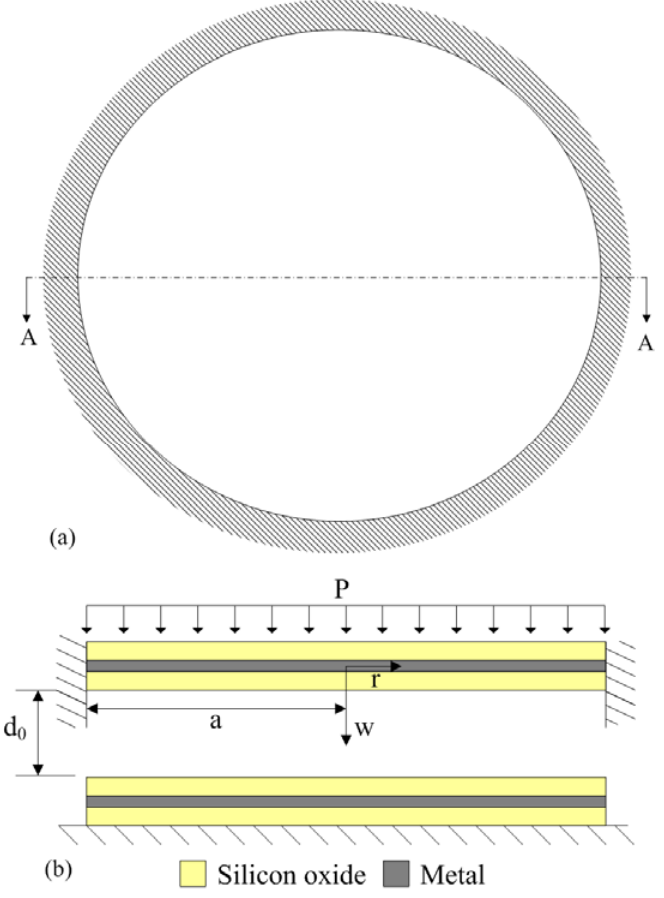
Figure 2. Schematic structure of a sensing cell, (a) top view; (b) AA cross-sectional